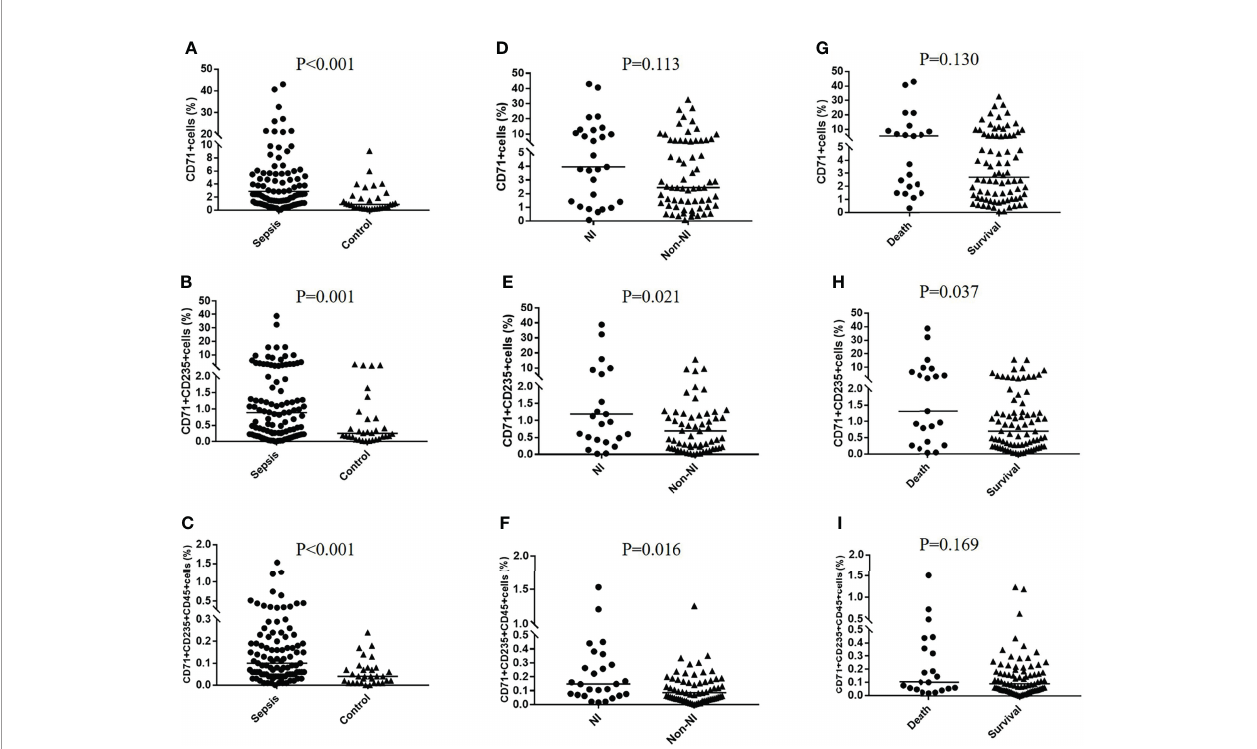
FIGURE 3 | CD71 + cells, CECs, and CD45 + CECs in different groups. The percentages of CD71 + cells, CD71 + CD235a + cells, and CD71 + CD235a + CD45 + cells were compared between the sepsis group and control group (A – C) , nosocomial infection (NI) group and non-NI group (D – F) , and death group and survival group (G – I) , respectively.